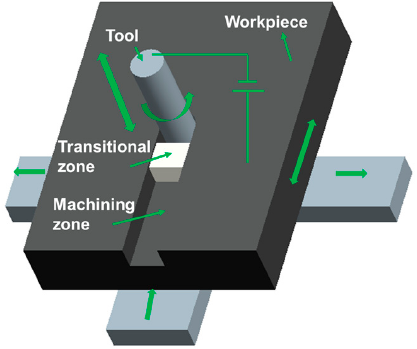
Figure 1. Mechanism of 2D-RUCEGM ultrasonic.